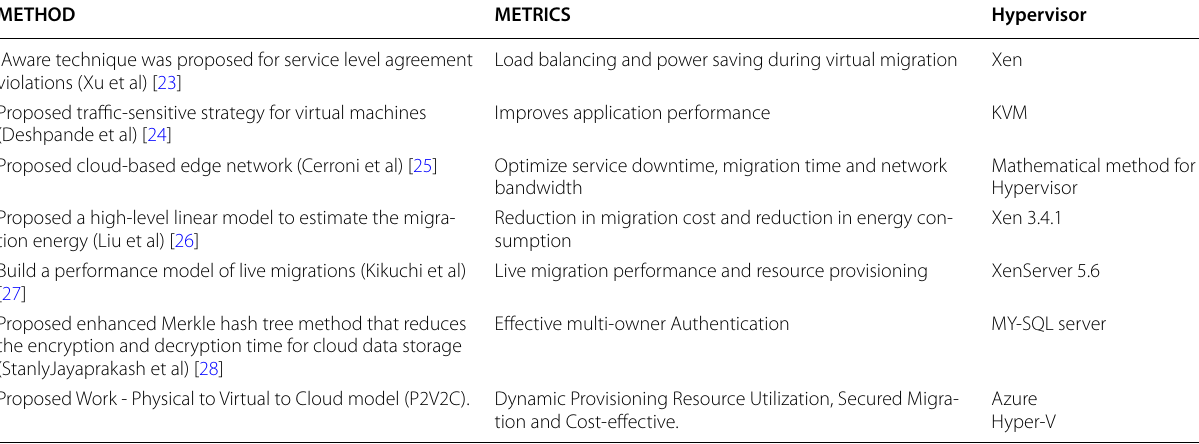
Table 1 Comparison of VM migration methods with the proposed work METHOD